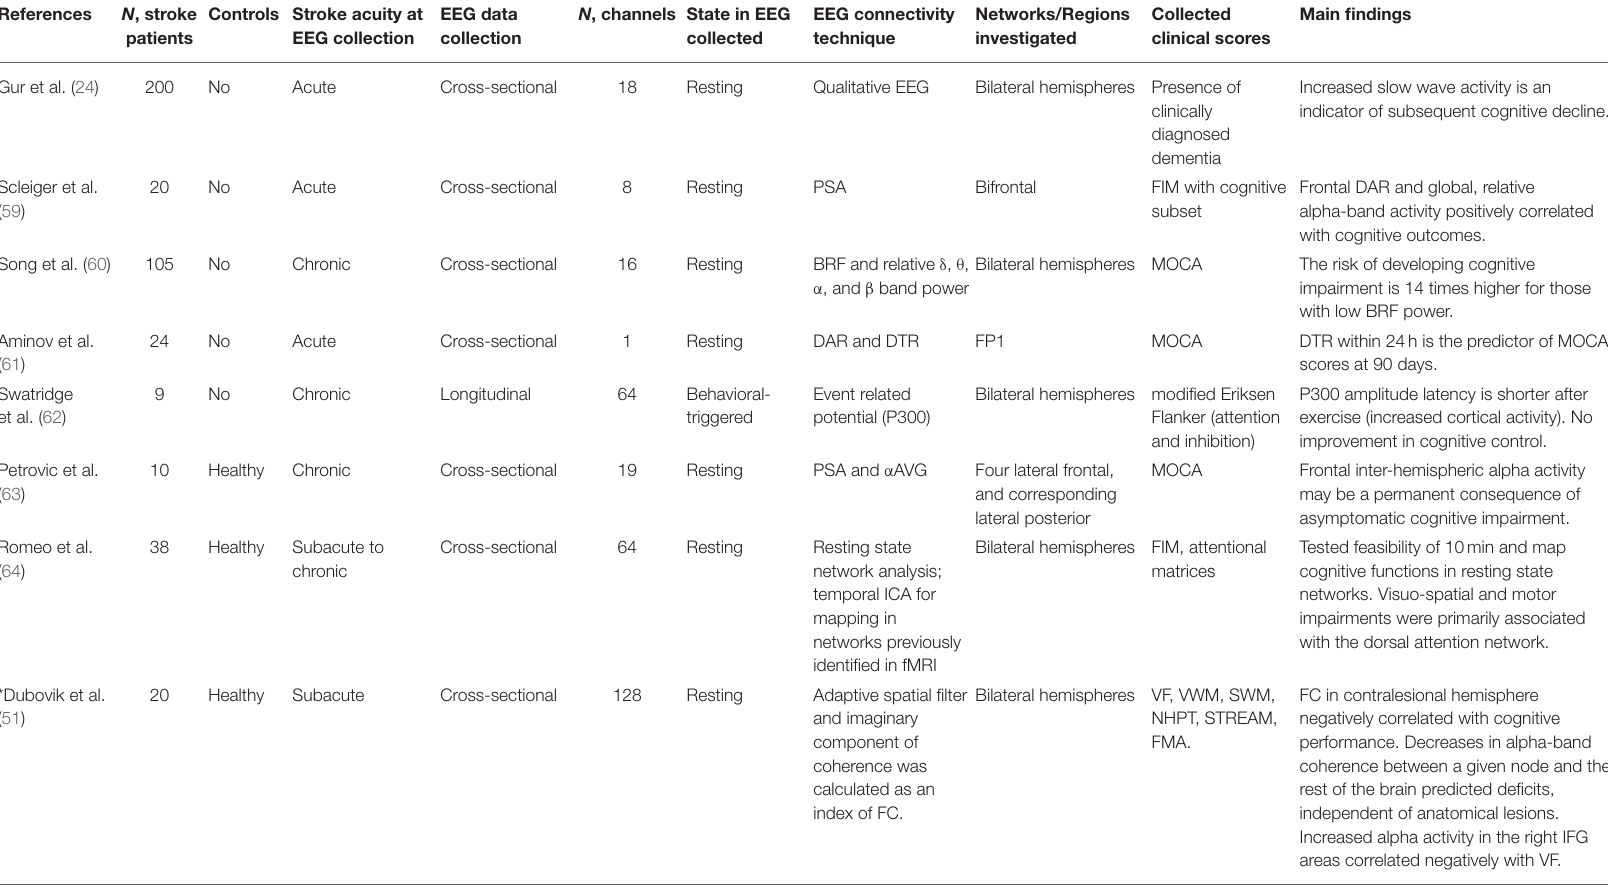
TABLE 3 | EEG studies of